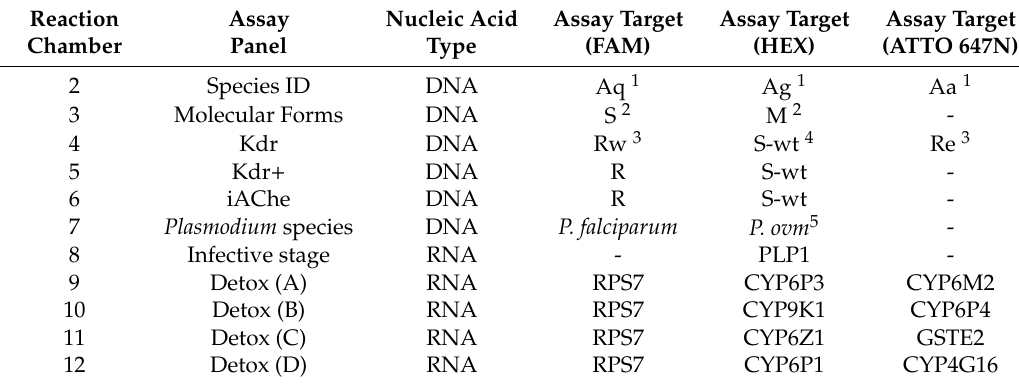
Table 1. VectorDisk assay panel for the Vector Study (triplex or duplex, depending on the assay of the VectorDisk). Targets are detected in 11 di ff erent reaction chambers and in three di ff erent detection channels (FAM-green, HEX-yellow, and ATTO 647N-red), detecting the fluorescence signal from the corresponding fluorophores in brackets.